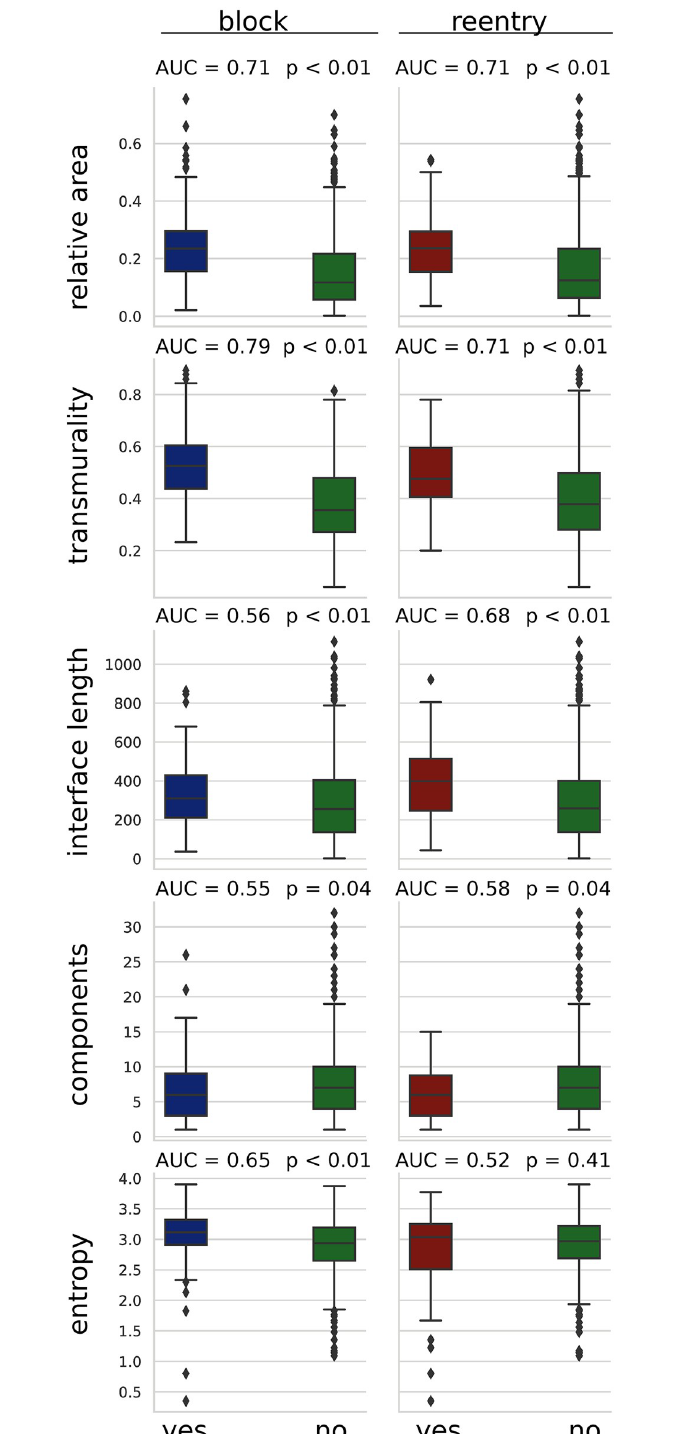
Fig 5. Boxplots showing the distribution of image feature values for images that had at least one simulated block vs no block (right column) or at least one simulated reentry vs no reentry (left column). AUC scores are area under curve in a receiver operating curve analysis for each feature’s ability to predict either reentry or block for a given image.